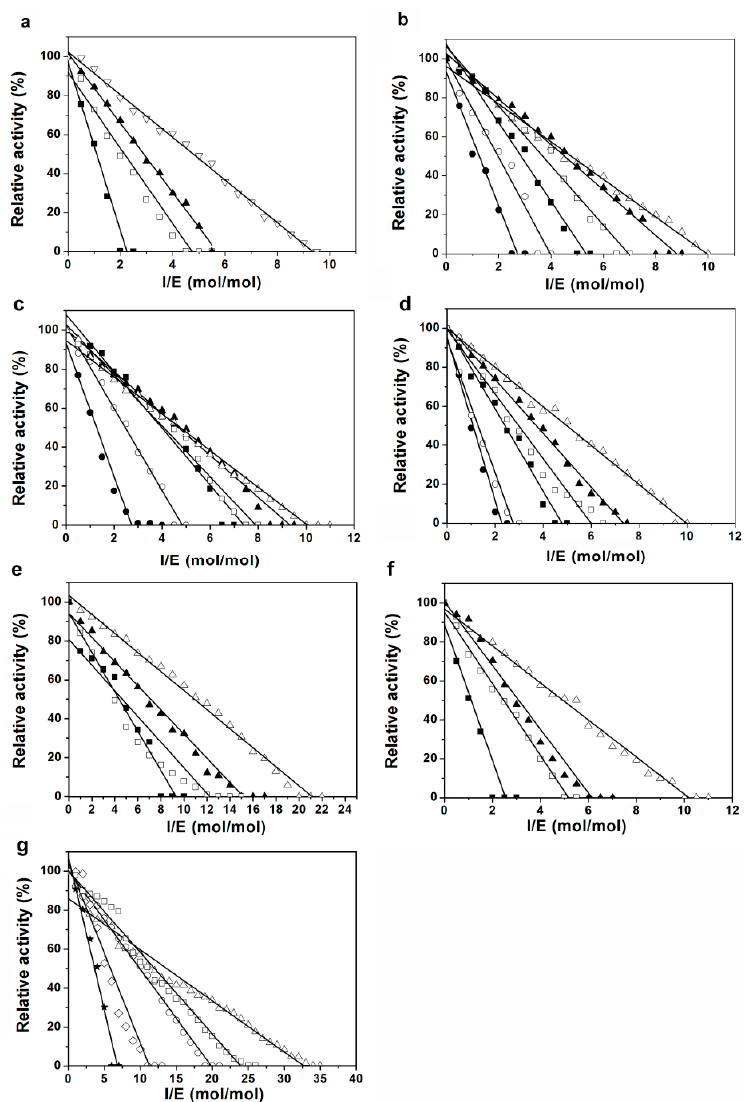
Figure 3. Effect of Pnserpin:protease molar ratio and temperature on protease inhibition by Pnserpin. CHT ( a ), SUC ( b ), elastase ( c ), PRK ( d ), thrombin ( e ), trypsin ( f ), and PnCHT ( g ) were incubated with Pnserpin (inhibitor) at various molar ratios at 20 °C ( ∆ ), 30 °C ( ▲ ), 40 °C ( □ ), 50 °C ( ■ ), 60 °C ( ○ ), 70 °C ( ● ), 80 °C ( ◇ ) and 100 °C ( ★ ). Table 1. Stoichiometry of inhibition (SI) values of Pnserpin for serine proteases.